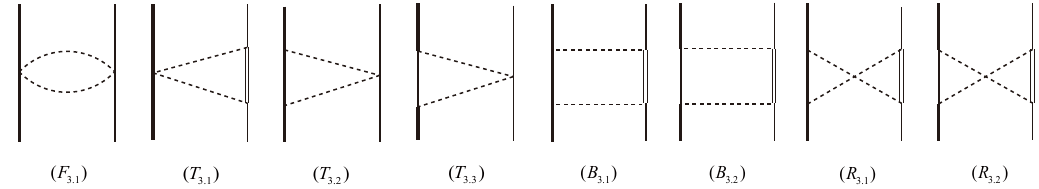
(cid:22) D system at O ( (cid:15) 2 ). The internal heavy c